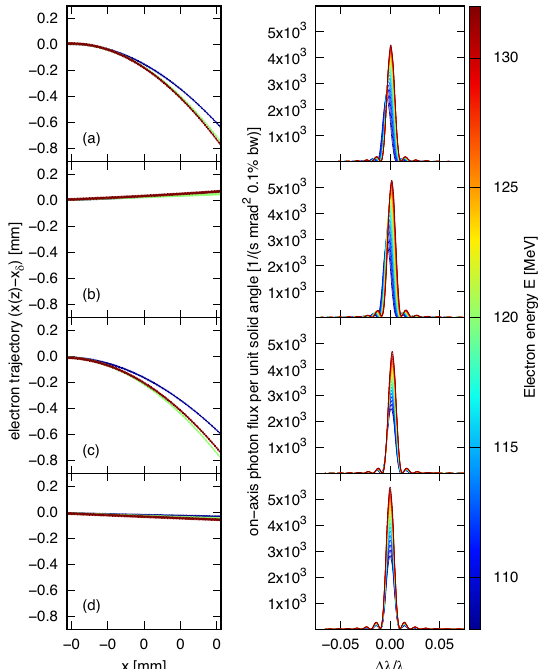
FIG. 6. The effect of the ponderomotive particle drift in TGUs: (a) linear TGU without trajectory correction and (b) with correction, (c) cylindric SCTGU without trajectory correction and (d) with correction.